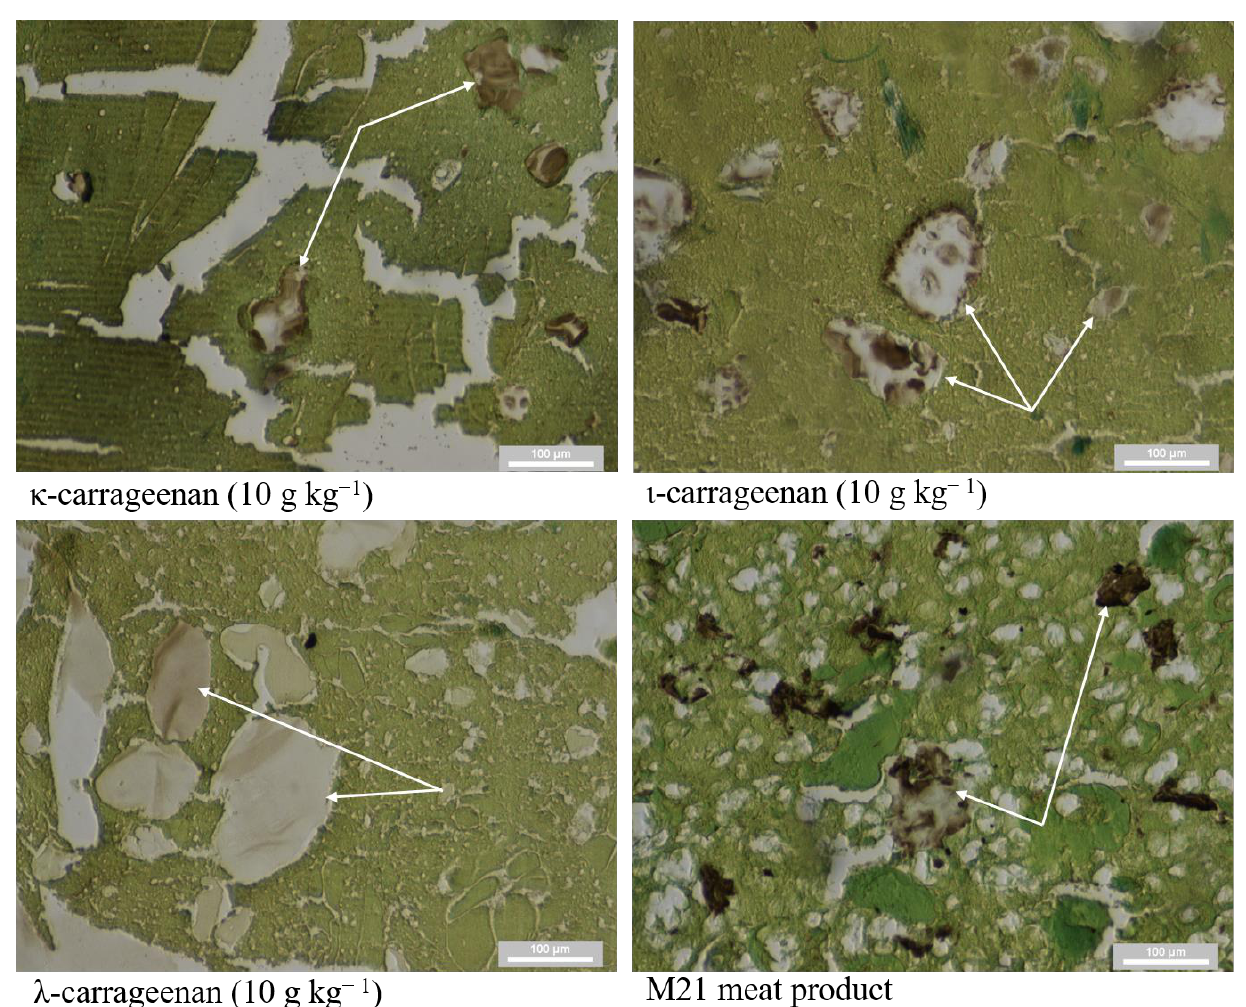
Figure 1. Positive reactions in tested matrices: carrageenan visualized in brown (arrows) model samples ( κ -, ι - and λ -carrageenan, with a concentration of 10 g kg −1 ) and a marketed meat product (M21). Table 3. Results of LoD determination of κ -, ι - and λ -carrageenan in model samples of meat